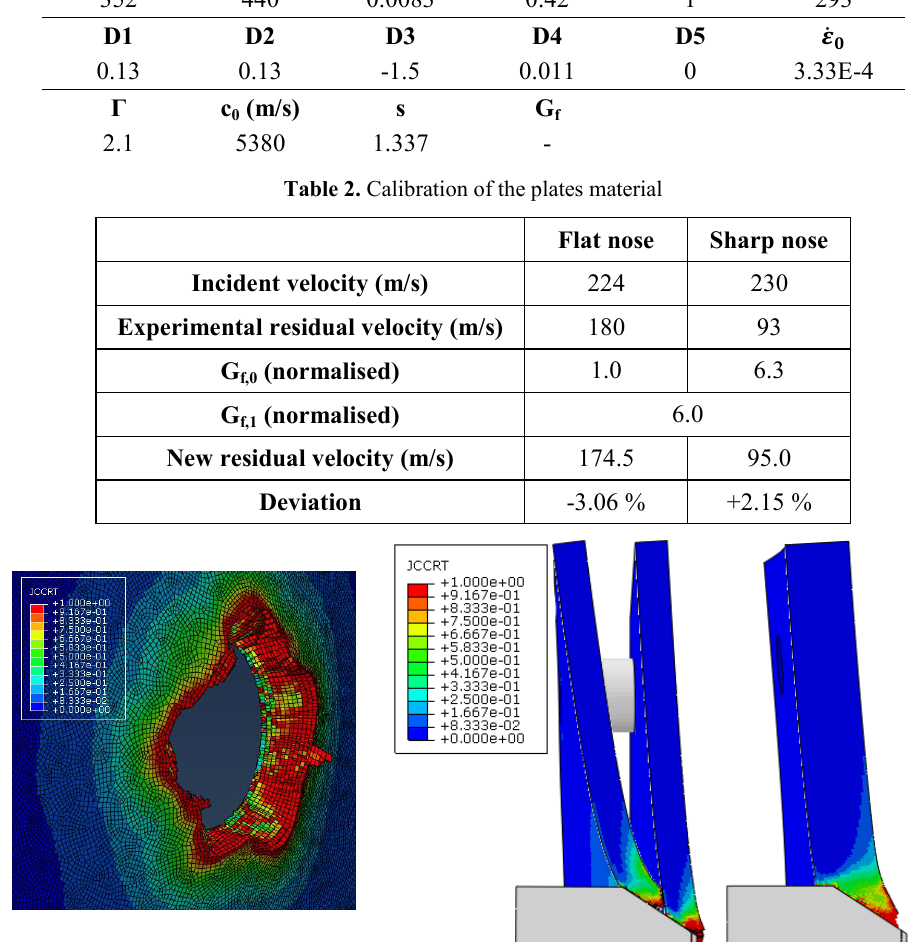
Fig. 3. Simulation on single Fig. 4. Simulation of a sharp-nosed projectile impacting at aluminium plate at 230 m/s. Johnson- 226 m/s a multi-layered protection system (2×6 mm), and a Cook damage initiation field. mono-layer version (1×12 mm). Johnson-Cook damage initiation field.